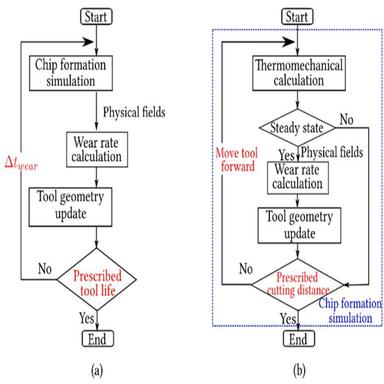
Comparison of the strategies of wear simulation. (a) The traditional modelling approach with wear increment and (b) the wear simulation within a continuous chip formation simulation by Zhang et al. .